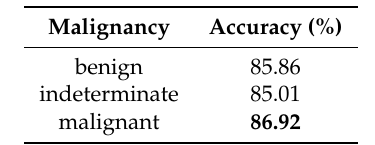
Table 4. Classification accuracy for each class, the best result is in bold.